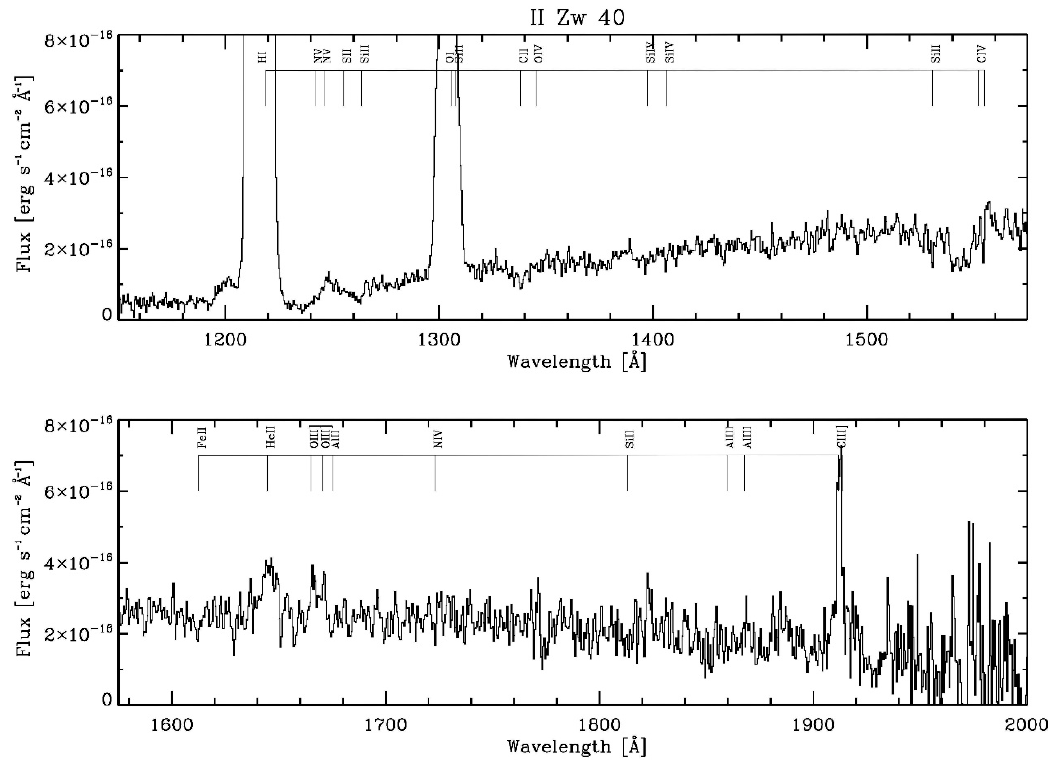
Figure 17. Observed UV spectrum of SSC-N. No correction for reddening or redshift was applied. Line identifications are above each spectrum. From [76].